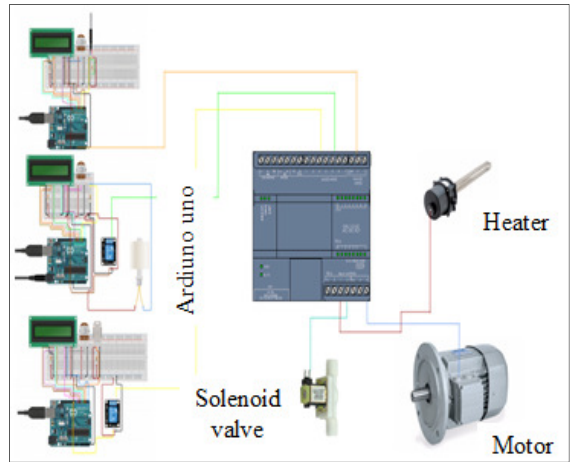
Fig. 2. (The Designed Circuit of the Project).